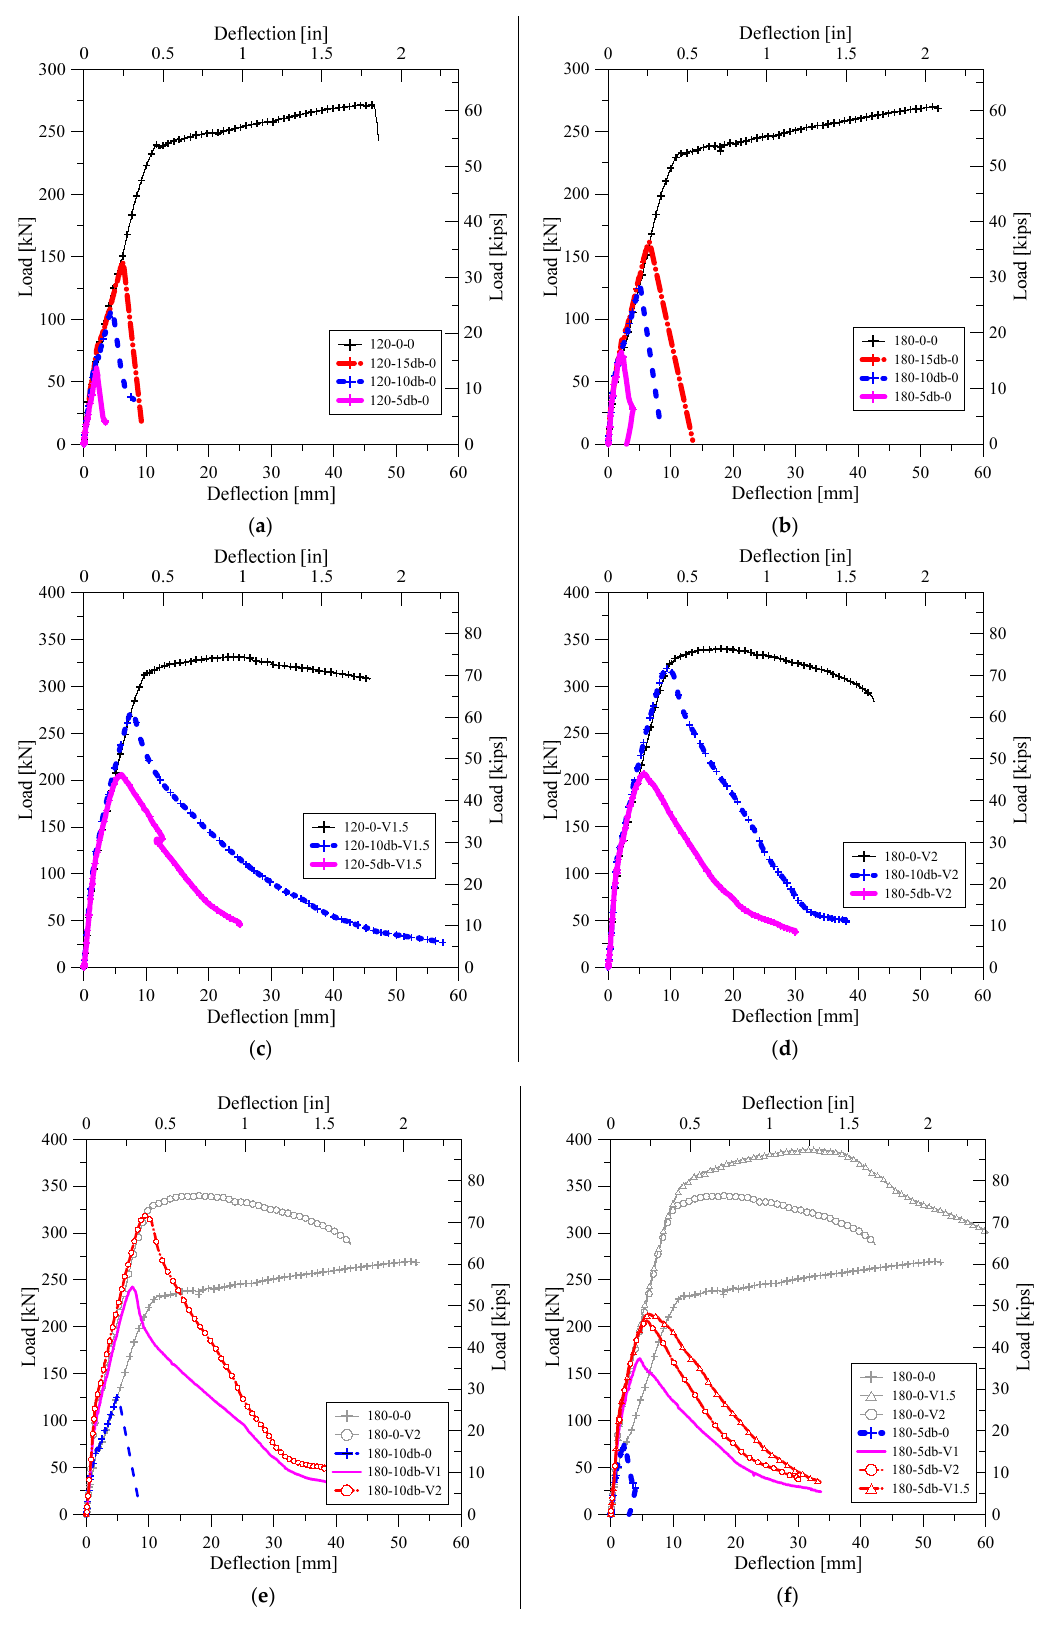
Figure 7. Load-deflection relation of tested specimens: ( a ) Specimens with 120-0 matrix; ( b ) Speci- mens with 180-0 matrix; ( c ) Specimens with 120-V1.5 matrix; ( d ) Specimens with 180-V2.0 matrix; ( e ) Specimens with 10 db lap length; ( f ) Specimens with 5 db lap length–effect of steel fiber.